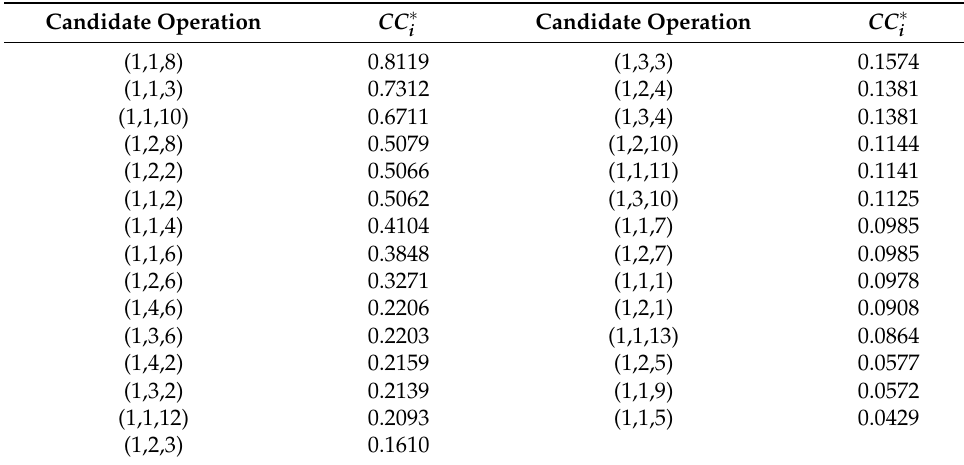
Table A12. Priority index of eligible operations—1st iteration.